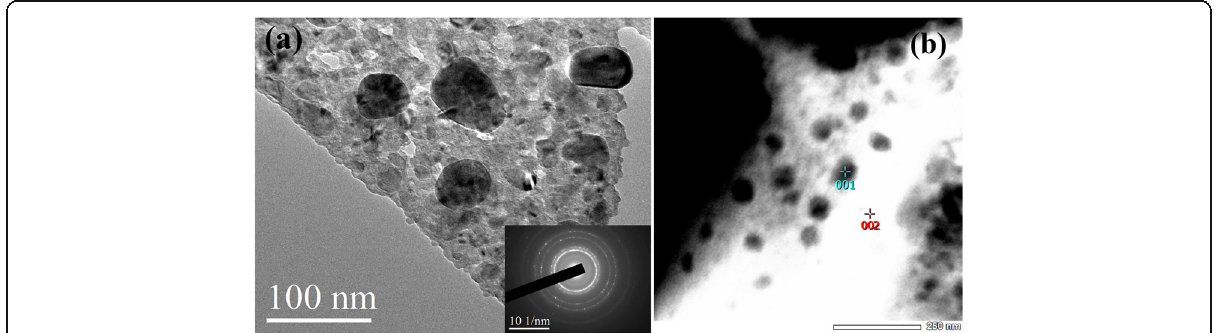
Fig. 5 a Bright field TEM image of the RE 13.6 Fe 78.4 B 8 with 7 wt.%Dy 2 O 3 and 2.3 wt.%Ca co-dopants (inset: selected area diffraction pattern); b STEM image showing the dark coarse